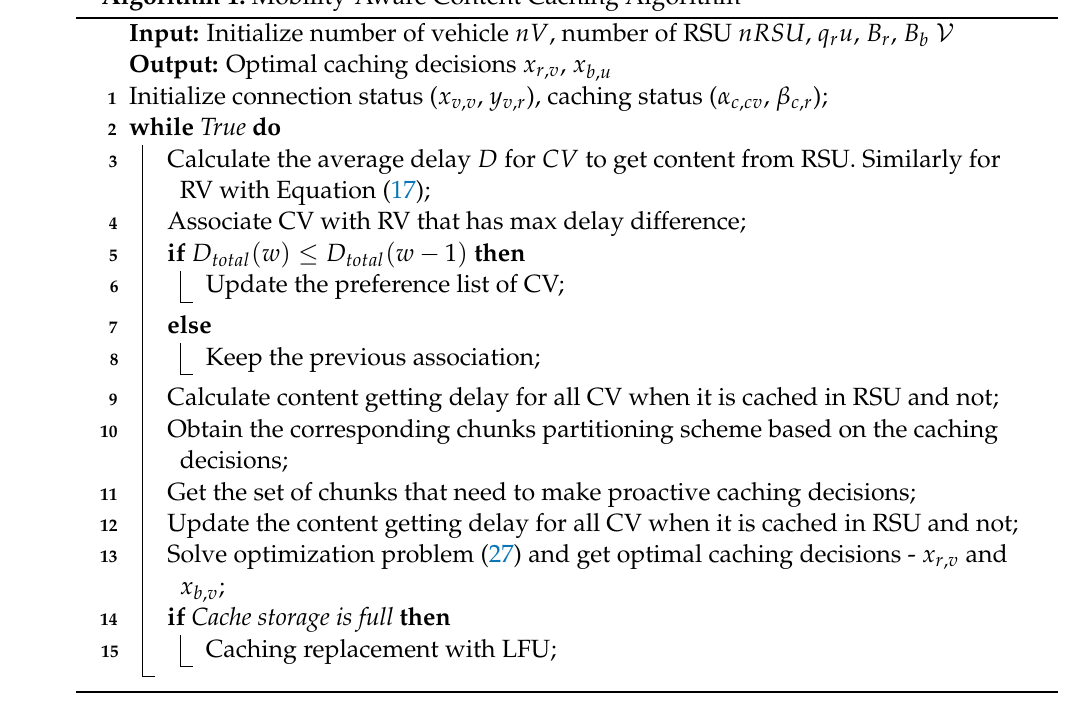
Algorithm 1: Mobility-Aware Content Caching